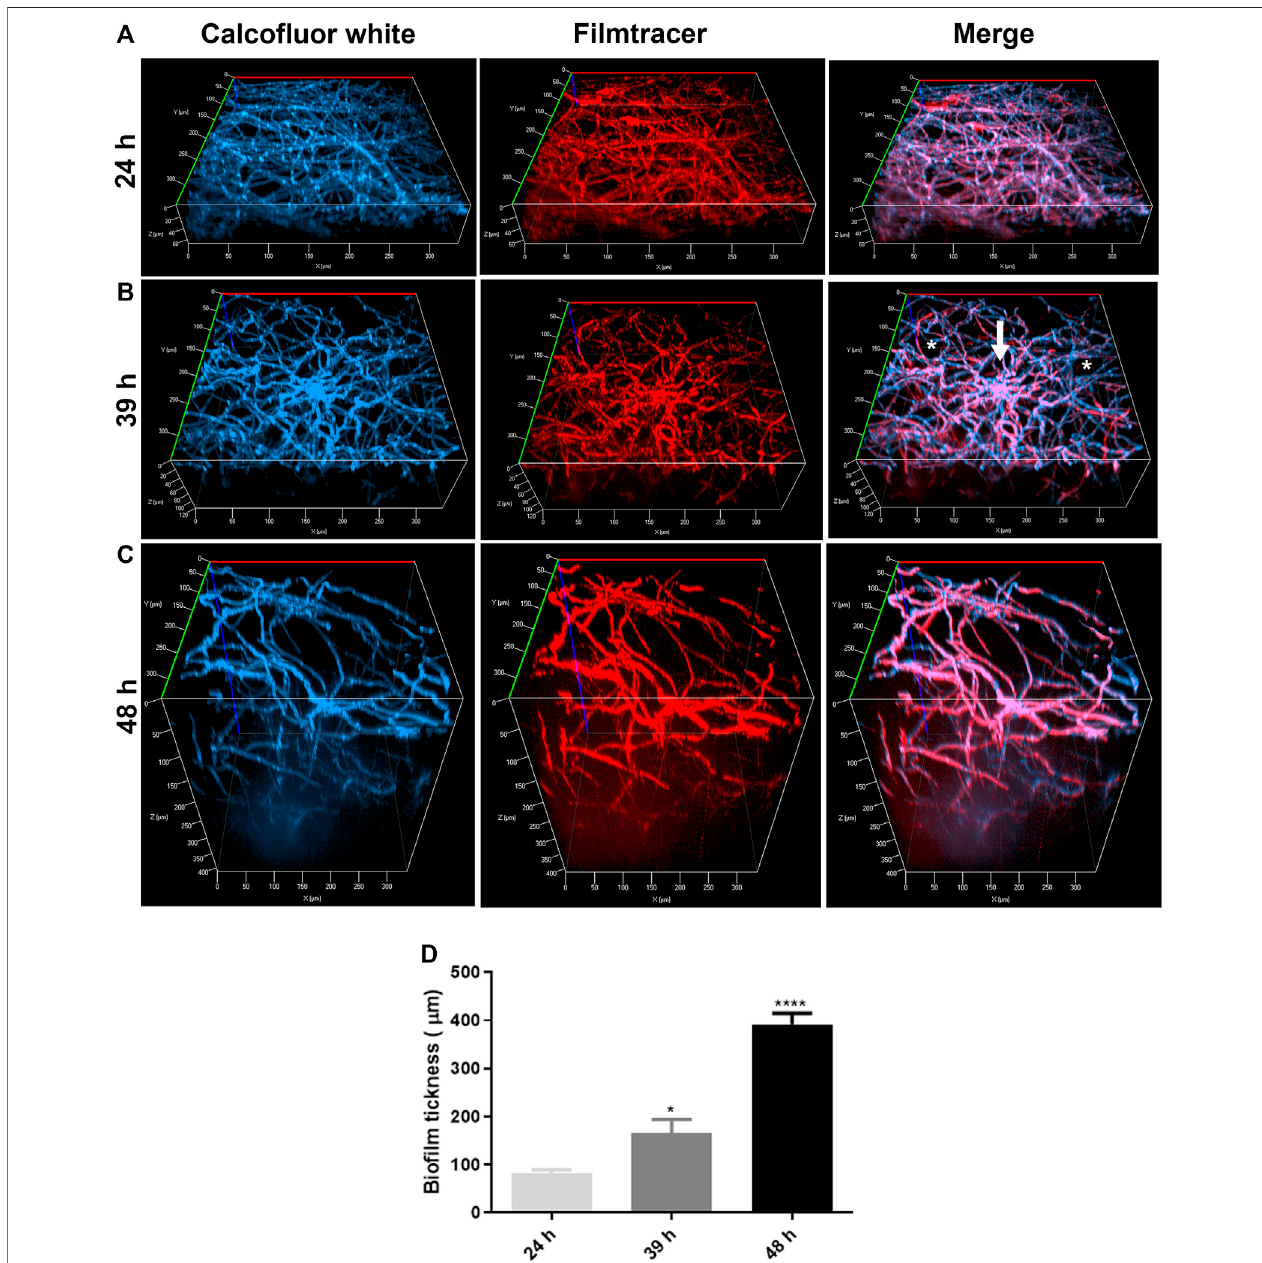
FIGURE 3 | Confocal fl uorescence microscopy images of A. nidulans bio fi lms formed in 24, 39, and 48 h. 1 × 10 4 conidia/mL were incubated in YUU medium in cell-view glass-bottom culture dishes at 37 ° C for (A) 24, (B) 39, and (C) 48 h. After each time, cell walls were stained with Calco fl uor white ( fi rst column), and the glycoproteinsfromtheextracellularmatrixwerestainedwithFilmtracerSyproRuby(secondcolumn).ThethirdcolumnrepresentsthemergeviewofCalco fl uorwhiteand Filmtracer Sypro Ruby signals. The images showed the three-dimensional reconstruction of the bio fi lm formed at each time. The asterisks represent the water channels,whereasthearrowrepresentsthecentralstructureofthebio fi lm.Magni fi cationof20xwasusedinallpanels. (D) Thicknessaverageof A.nidulans bio fi lmat24, 39, and 48 h. The average was calculated by measuring the length of the z -axis (µm) of three fi elds for each time of bio fi lm formation. Error bars represent standard deviations from the mean of two independent experiments performed in duplicate. Statistical differences ( p < 0.05) are represented by asterisks, for comparisons between 39-h bio fi lms and 24-h bio fi lms and between 48-h bio fi lms and 39-h bio fi lms; * p < 0.05, **** p < 0.0001.